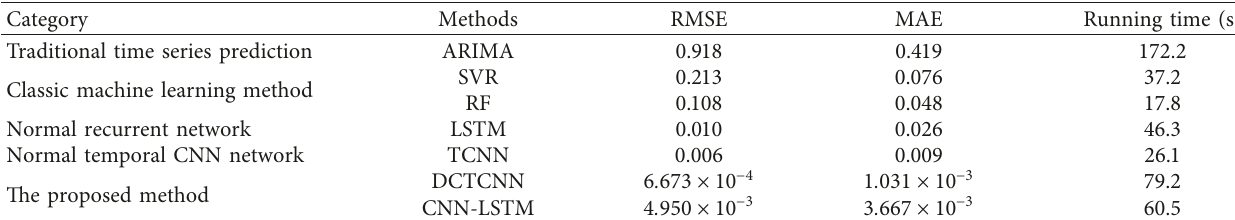
Table 2: Seven compared methods performance on UCI seismic bumps